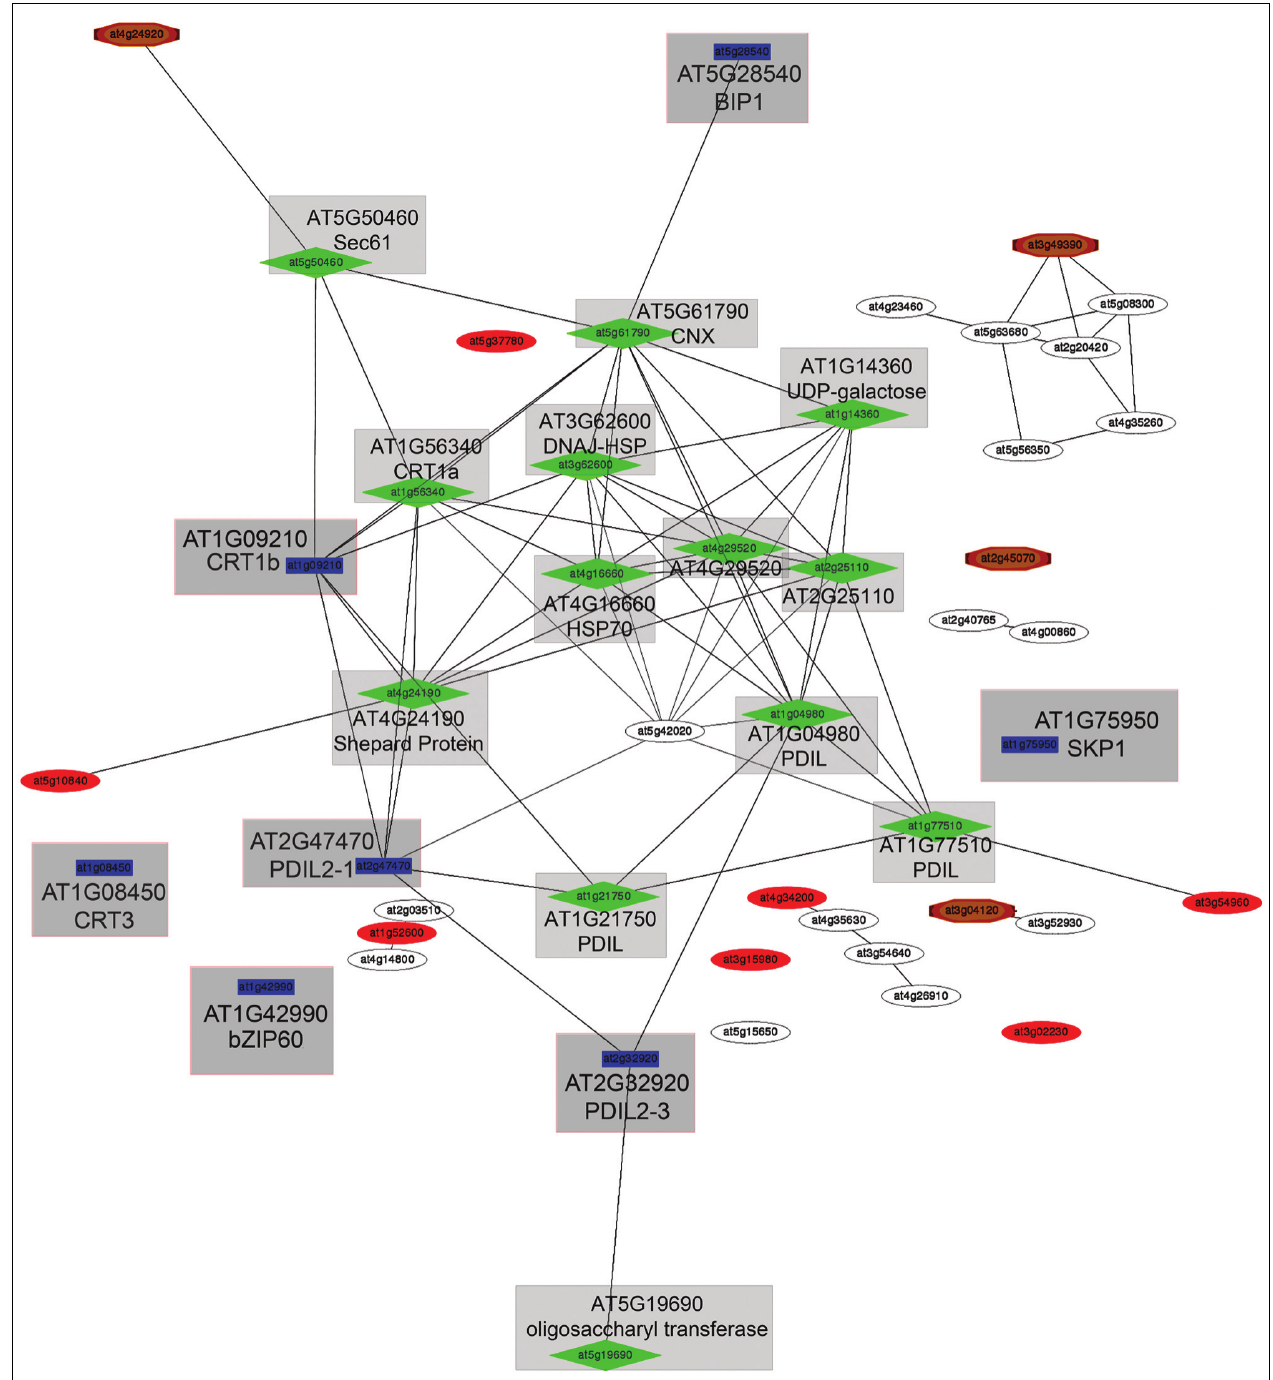
mutual ranks according to GeneCAT webtool analysis (Mutwil etal., 2008; Usadel etal., 2009). Query genes including bZIP60, SKP1, and CRT3 do have lines connecting them to the co-expressed gene network arguing that they are not connected in a manner that is statistically relevant. Thus the evidence that these genes are upregulated early in virus infection could suggest that the virus may be interacting with more than one signaling pathway. Each blue and green labeled node, has a gray box with the name of the gene and its accession highlighted in larger print.